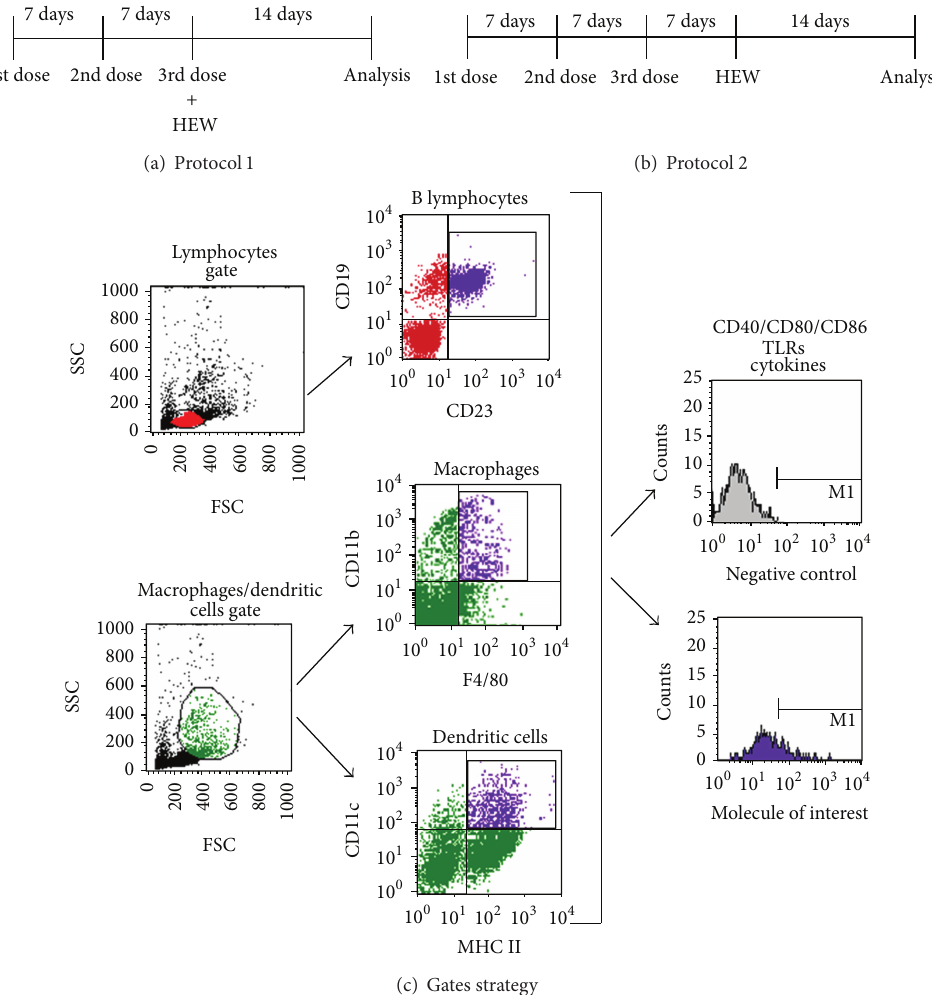
Figure 1: Schematic representation of P. acnes - and PS-treatment protocols and gates strategy. F1 BALB/c x A/J mice were subcutaneously injected with P. acnes or PS once a week, during 3 weeks. Heat-coagulated hen’s egg white (HEW) was implanted concomitantly to the last P. acnes or PS dose in Protocol 1 (a) or 1 week after the third dose in Protocol 2 (b). For each protocol, the respective control group was treated with 350 𝜇 L of sterile commercial 0.9% saline, at the same conditions. Spleen cells were analyzed 14 days after HEW implantation. (c) Gates strategy used for flow cytometry